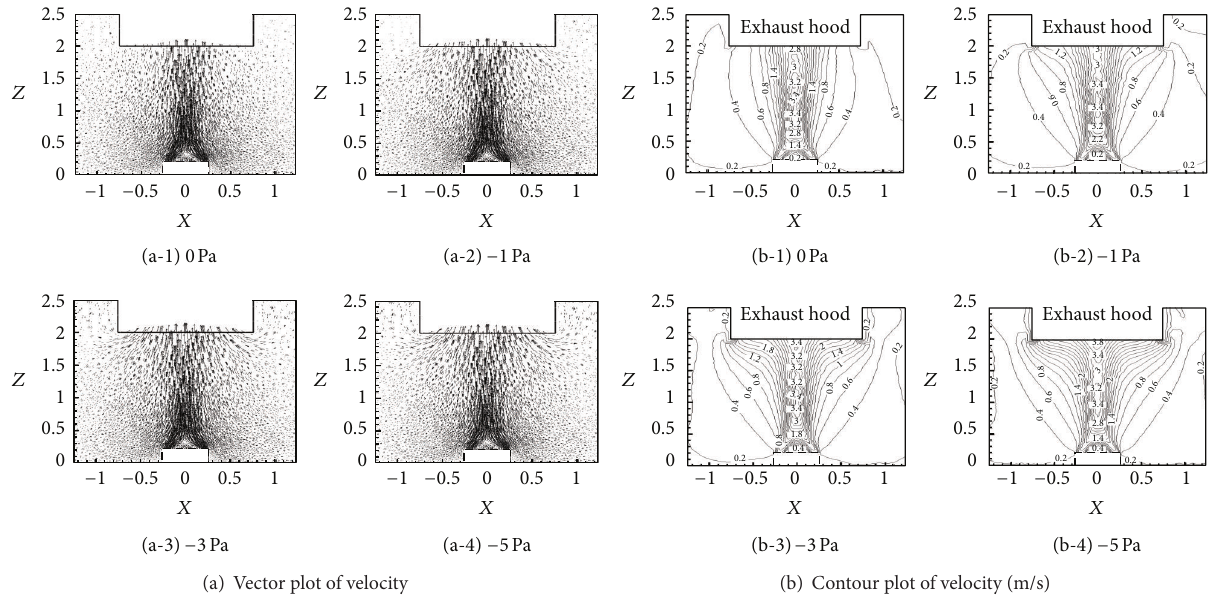
(a) Vector plot of velocity (b) Contour plot of velocity (m/s) Figure 11: Velocity field characteristics of high-temperature annular buoyant jets with different pressures at the exhaust hood